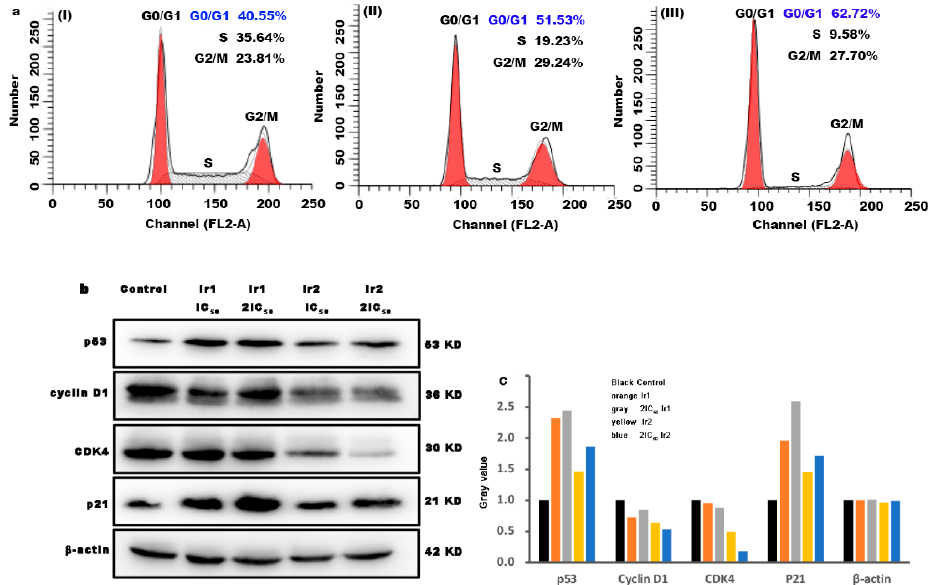
Figure 11. ( a ) Cell cycle arrest of HCT116 was treated with IC 50 concentration of Ir1 and Ir2 for 24 h. ( b ) Expression of p53, cyclin D1, CDK4 and p21 proteins after a 24 h treatment of HCT116 cells with IC 50 and 2IC 50 concentration of Ir1 and Ir2 for 24 h. ( c ) Gray values of the expression of p53, cyclin D1, CDK4 and p21